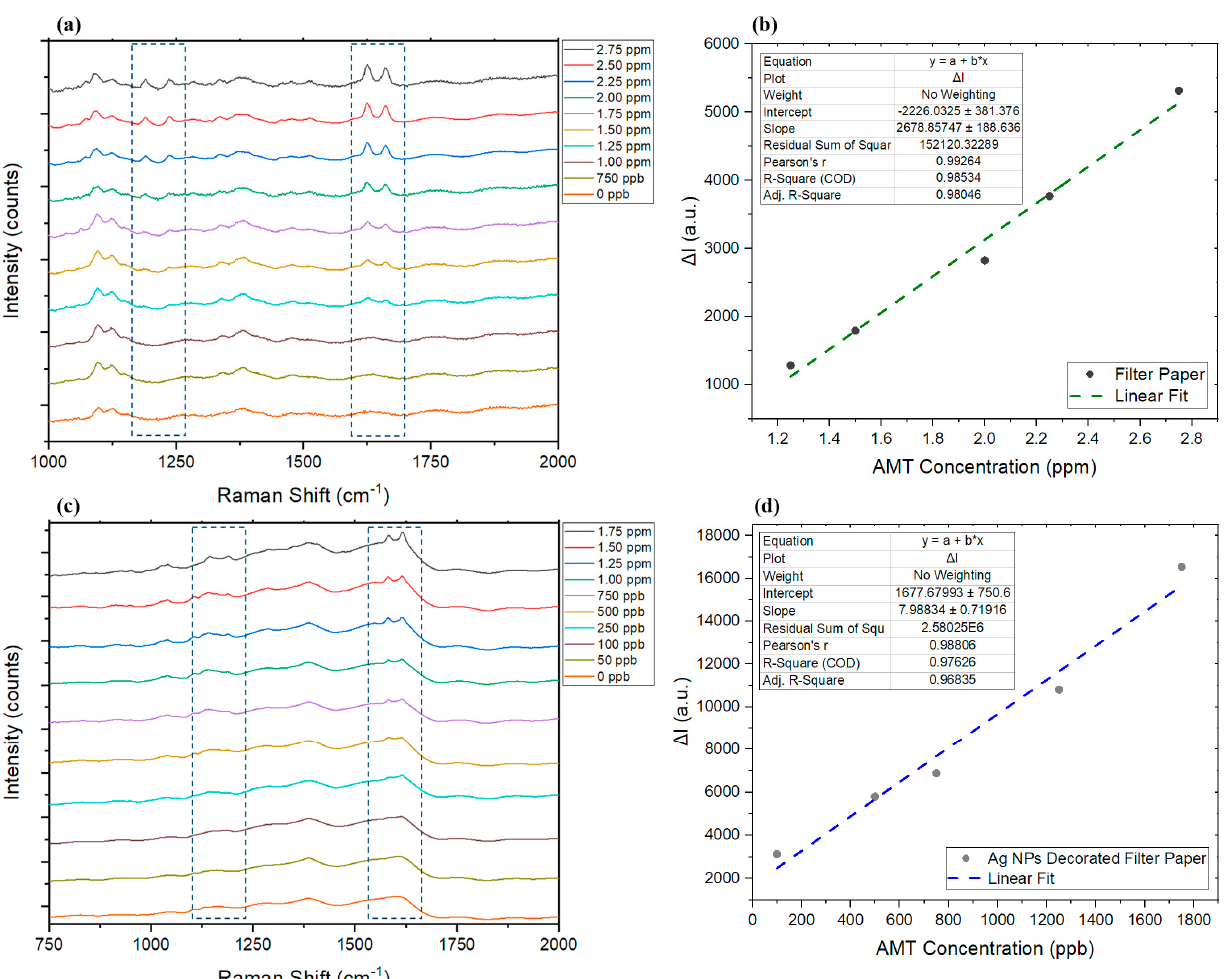
Figure 4. ( a ) Changes in the Raman spectra in the presence of different concentrations of AMT on the normal paper. ( b ) The linear range for each tested substrate. ( c ) The response of the AgNP-modified filter paper to changes in the concentration of AMT and ( d ) its linear range. ∆ I represents the changes in intensity in the presence of AMT compared to the Raman intensity at the peak wavelength of blank